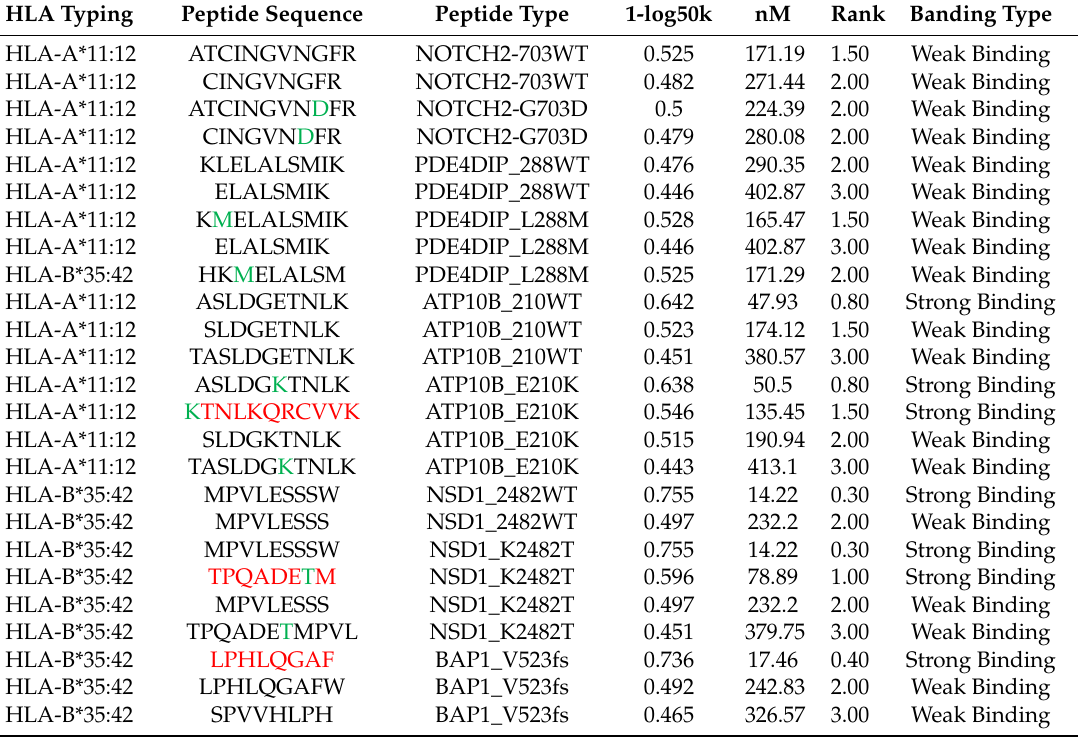
Table 3. All possible peptides bound to HLA-A, B molecules were listed: amino acids in green are mutant sites. Peptide sequences in red were predicted to have a strong binding ability to HLA molecules and are potential tumor-specific